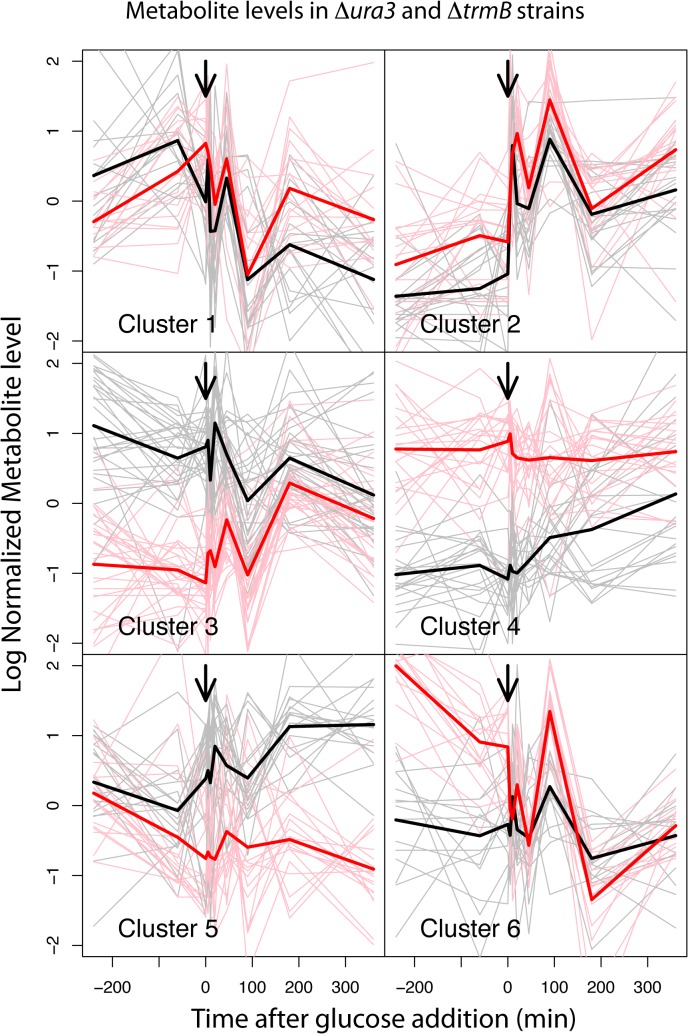
Clustering of metabolite patterns.Figure depicts six clusters of metabolite patterns. Logged, mean-scaled and normalized combined Δura3 (black lines) and ΔtrmB (red lines) data are shown. Each cluster graph depicts metabolite data for individual metabolites across 5 biological replicate cultures (thinner lines) and the mean expression profile for the cluster (thicker lines). Arrow depicts when glucose was added to a final concentration of 5%.